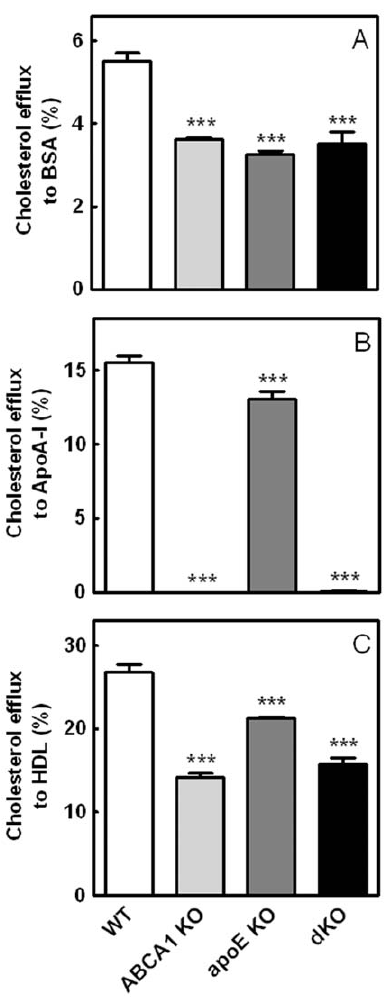
Figure 7. Invitro cellular cholesterol efflux. Cholesterol efflux from bone marrow-derived macrophages (BMDM) to BSA (A), apoA-I (10 m g/ mL; B) and HDL (50 m g/mL; C) was determined after 24 h. Data are expressed as the percentage of radioactivity released into the medium. Values represent the means of n $ 3 mice 6 SEM per group. ***p , 0.001 as compared to WT transplanted